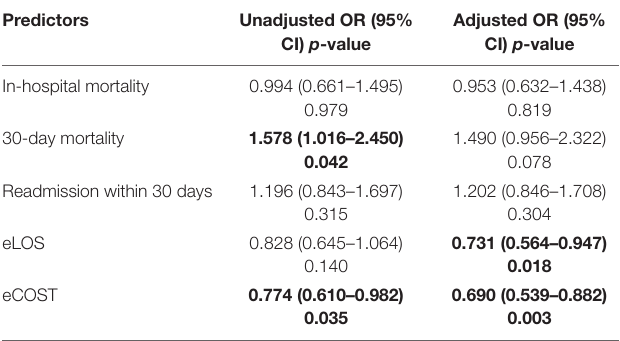
TABLE 2 | Logistic regression on association of geriatrician-led vs. non-geriatrician–led inpatient team on readmission within 30 days, in-hospital mortality, cost, and length of stay (non-geriatrician–led as reference